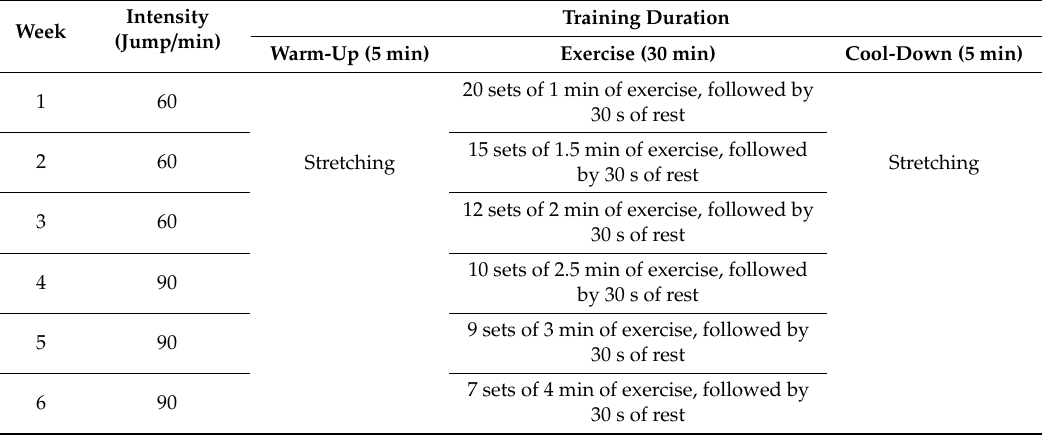
Table 1. Jump rope exercise protocol for the JW and JD